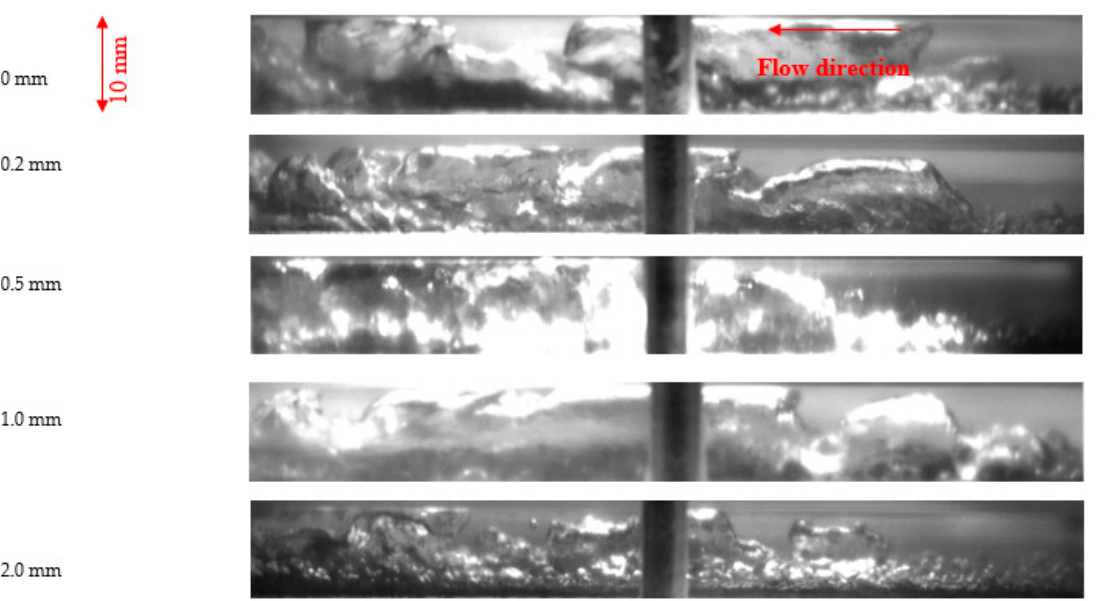
Figure 7. Flow and bubble formation pattern at the maximum heat flux for all the porous thickness: ∆ T sub = 30 K; G = 400 kg · m − 2 · s − 1 .